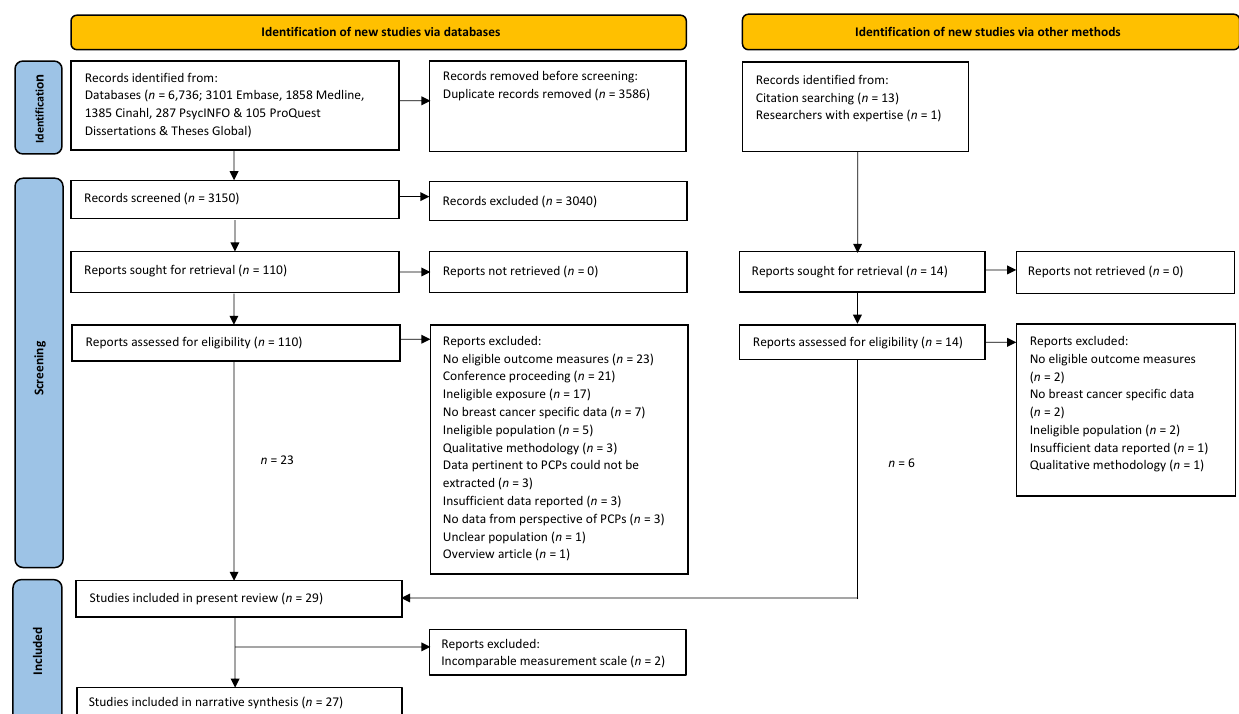
Figure 1. PRISMA flow diagram of study selection